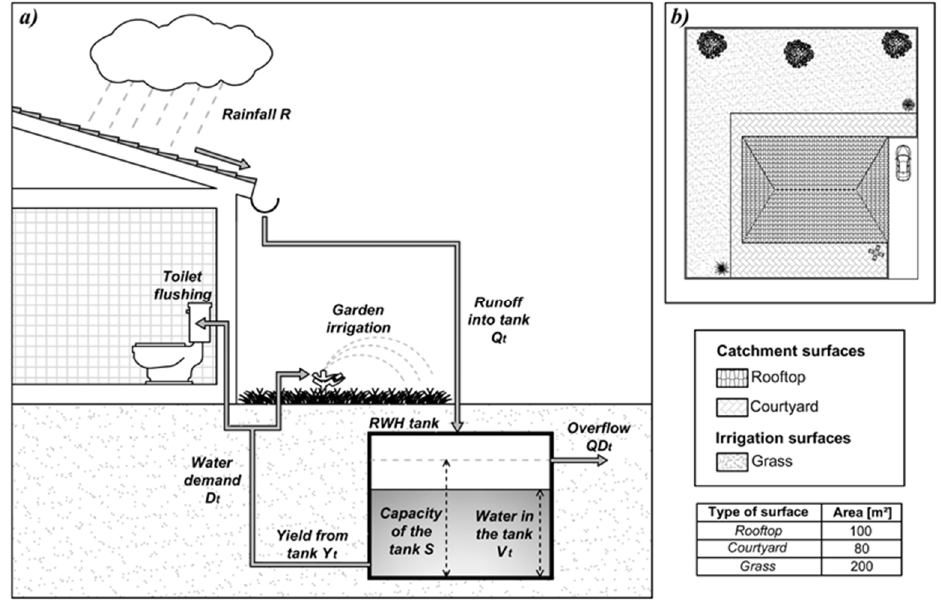
Figure 2. ( a ) Scheme of the RWH system; and ( b ) layout of the single-family house with the representation of the different surfaces.